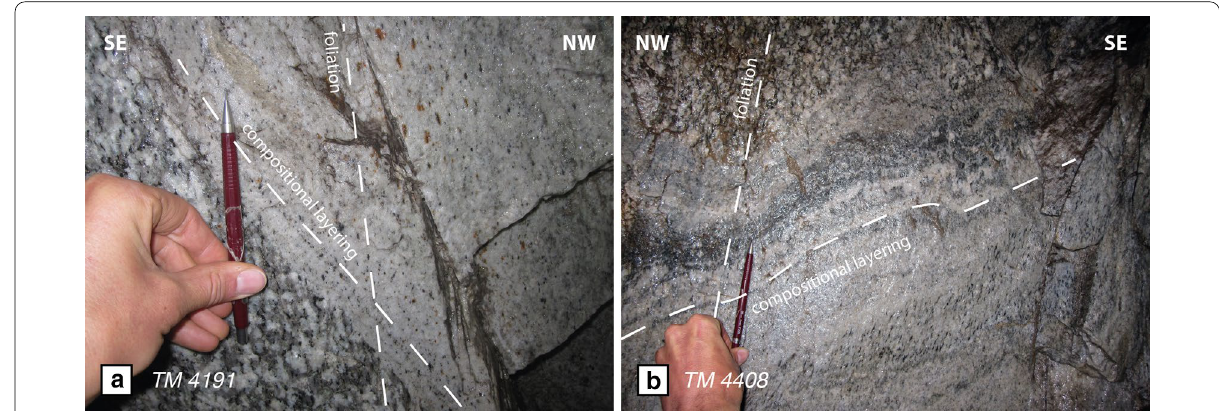
Fig. 8 Foliation in the Rotondo granite and its continuation into aplitic dykes with compositional layering at TM 4191 ( a ) and TM 4408 ( b ). Pencil for scale